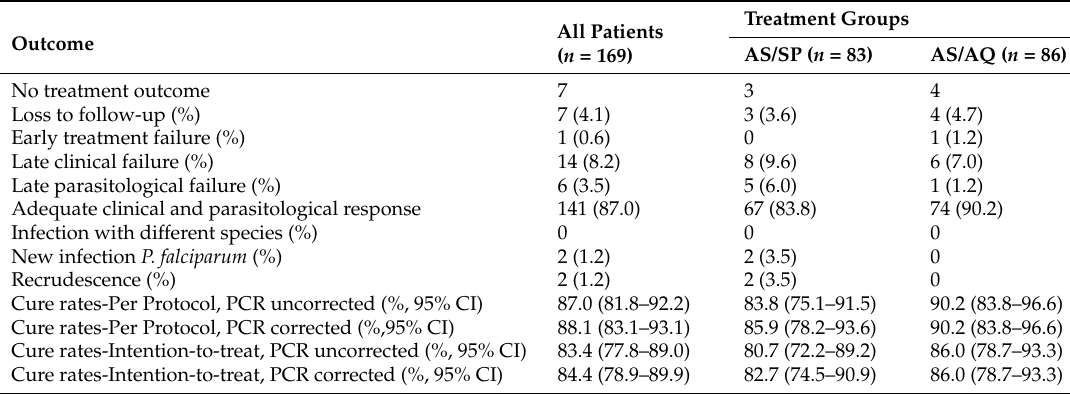
Table 2. Treatment outcomes of AS/SP and AS/AQ after day